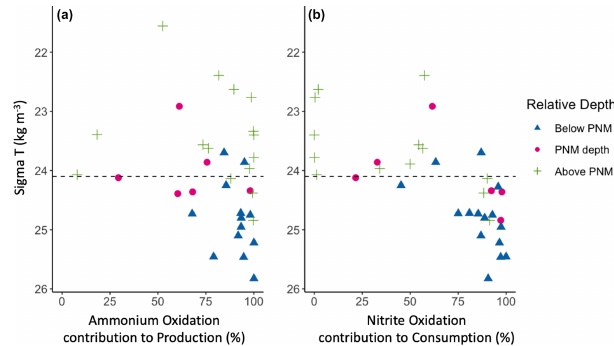
Figure 5. Contributions of nitrification to total nitrite production (a) and total nitrite consumption (b) across density space. Measure- ments are colored by depth relative to the station-specific depth of maximum nitrite; above the depth of maximum nitrite (green crosses), at the depth of maximum nitrite (magenta circles) or be- low the depth of maximum nitrite (blue triangles). The mean ETNP nitrite maxima isopycnal (24.1kgm − 3 ) is marked as a horizontal dashed